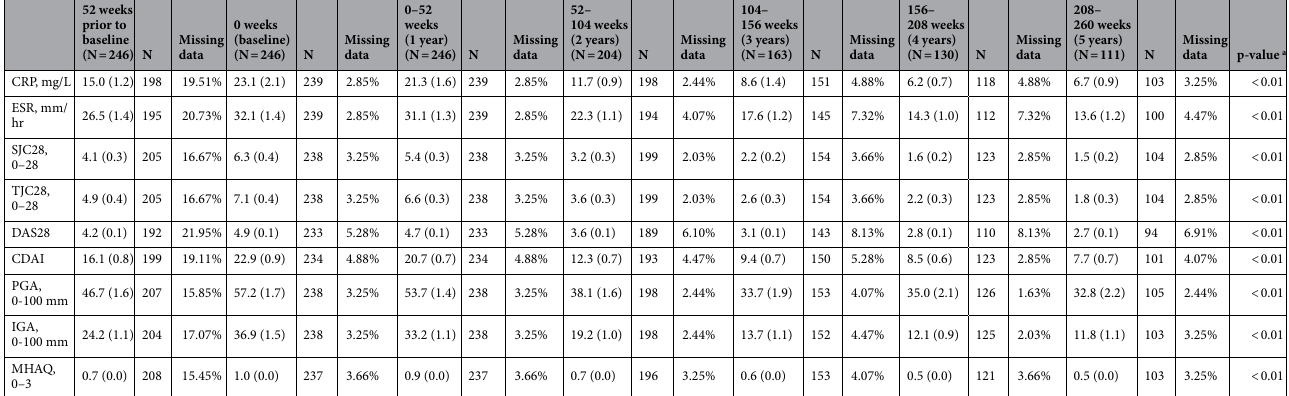
Table 2. Changes in disease activity and PRO measures for RA patients treated with ref-RTX. Data are presented as the mean with standard error (SE) of the mean. PRO patient-reported outcome, RA rheumatoid arthritis, Ref-RTX reference rituximab, CRP C-reactive protein, ESR erythrocyte sedimentation rate, SJC28 28 swollen joint count, TJC28 28 tender joint count, DAS28 disease activity score with 28 joint counts, CDAI clinical disease activity index, PGA patient global assessment, IGA investigator global assessment, MHAQ modified health assessment questionnaire. a p-value for difference between the observation times (random intercept linear mixed models).